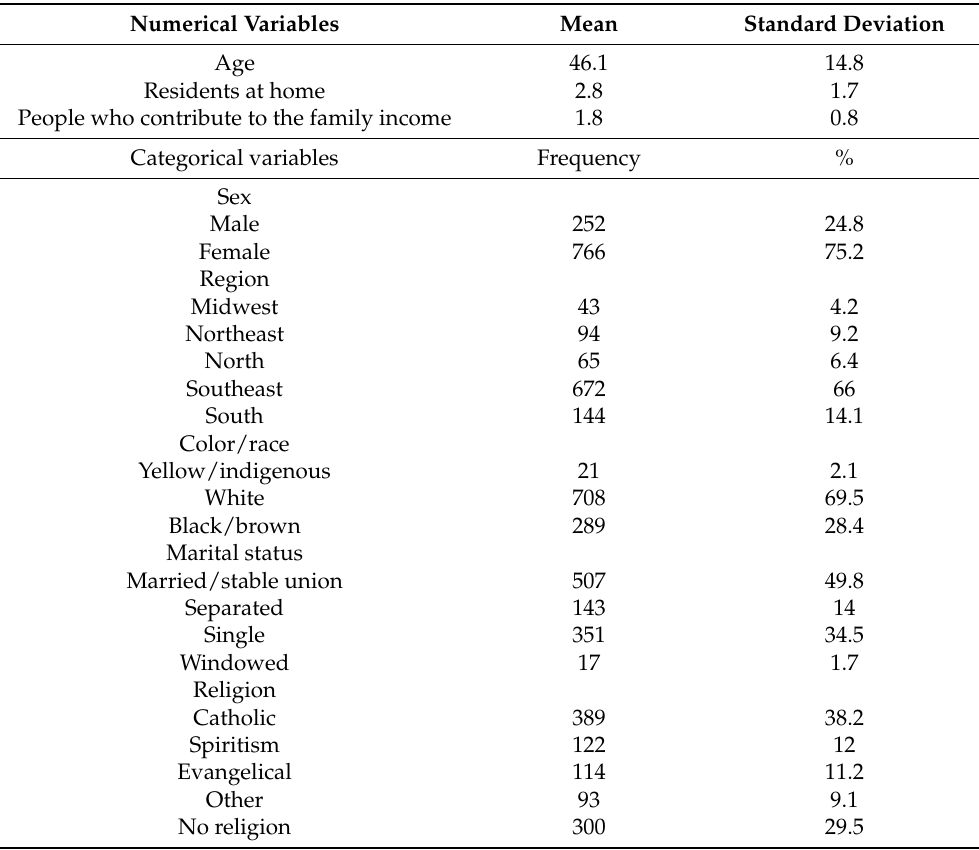
Table 2. Sociodemographic characteristics of the final study sample ( n =